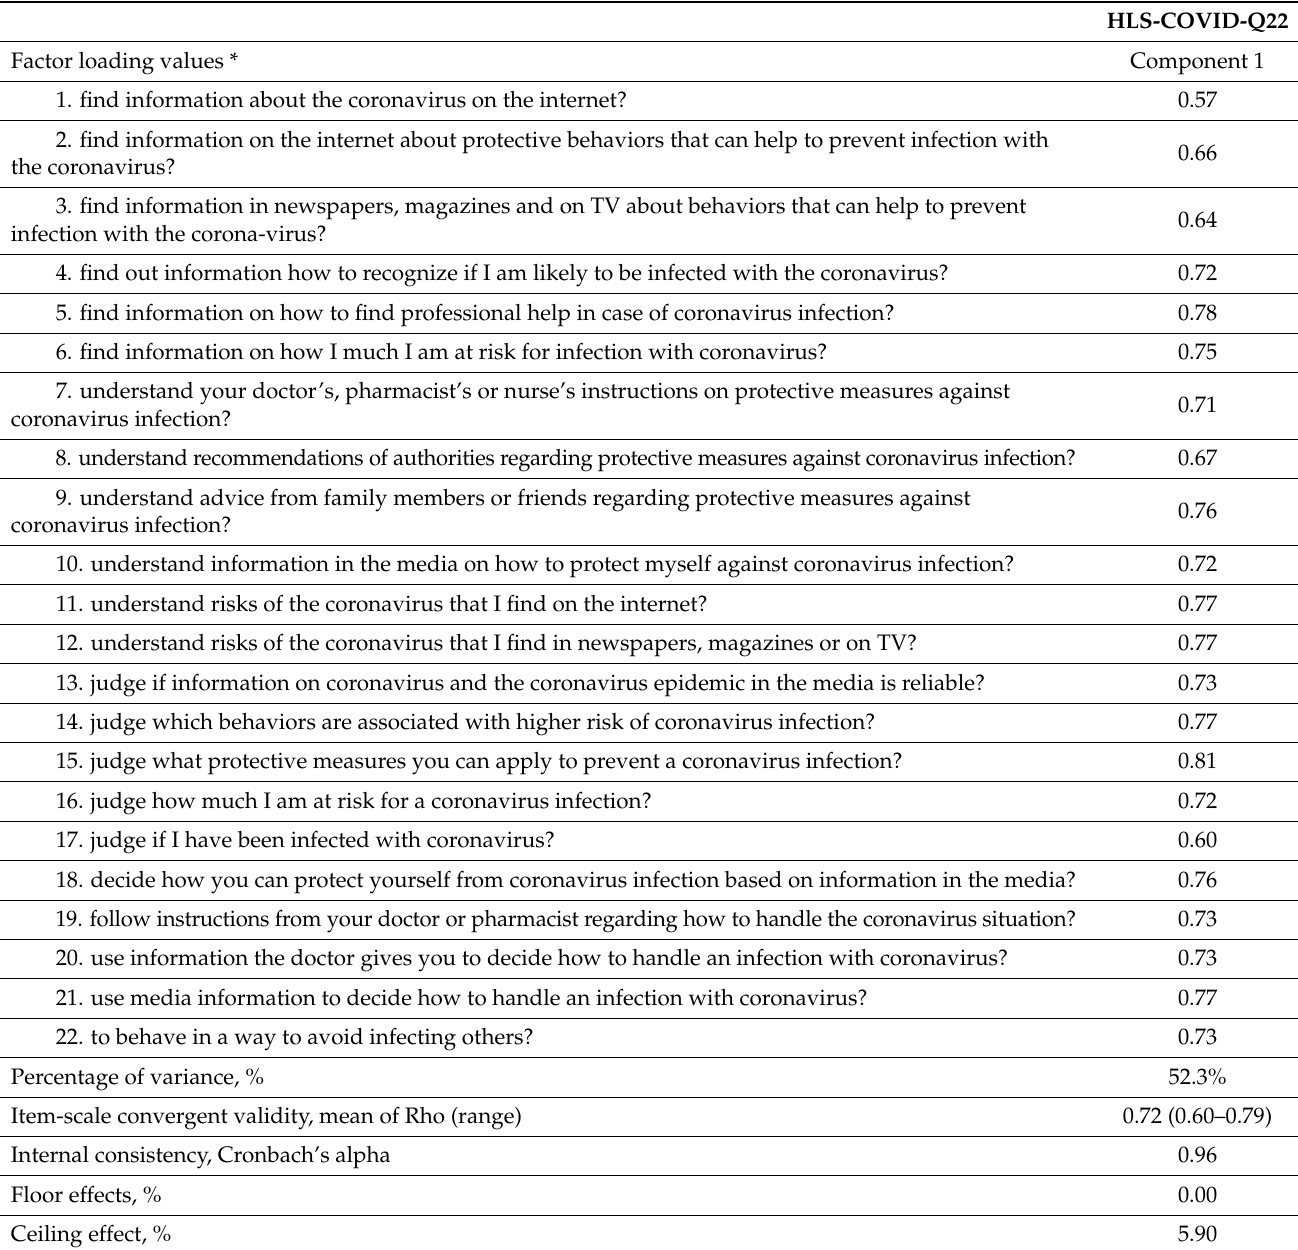
Table 2. Construct, convergent, internal consistency, floor and ceiling effects of Coronavirus-related health literacy ( n = 387).